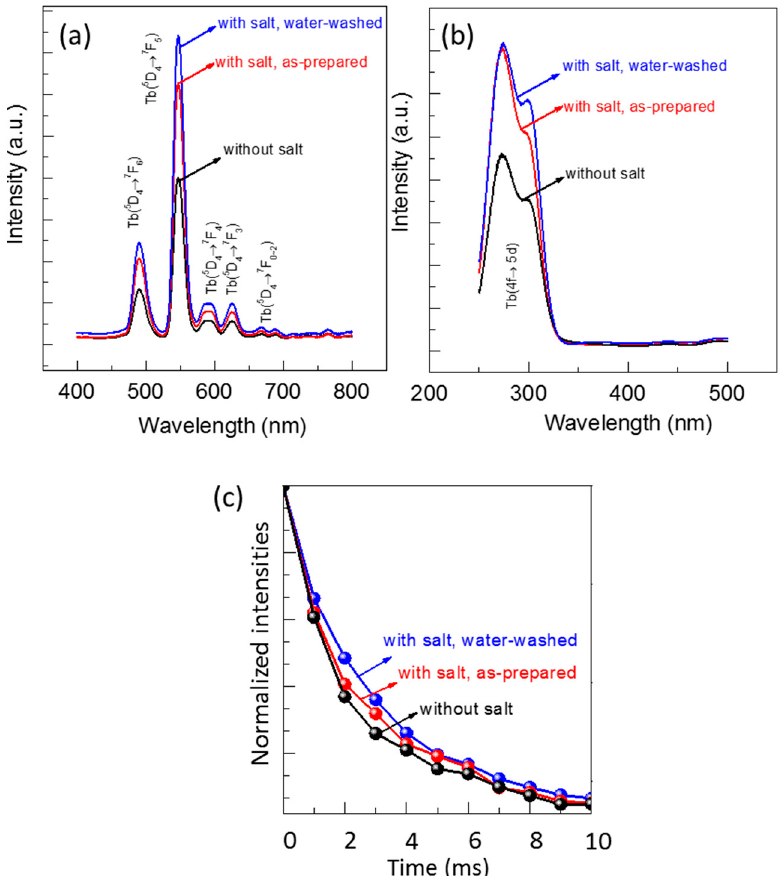
Figure 8. ( a ) Photoluminescence (PL) spectra for excitation at 365 nm; ( b ) photoluminescence excitation (PLE) spectra for emission at 547 nm; and ( c ) decay curves of emission at 547 nm and excitation at 300 nm.